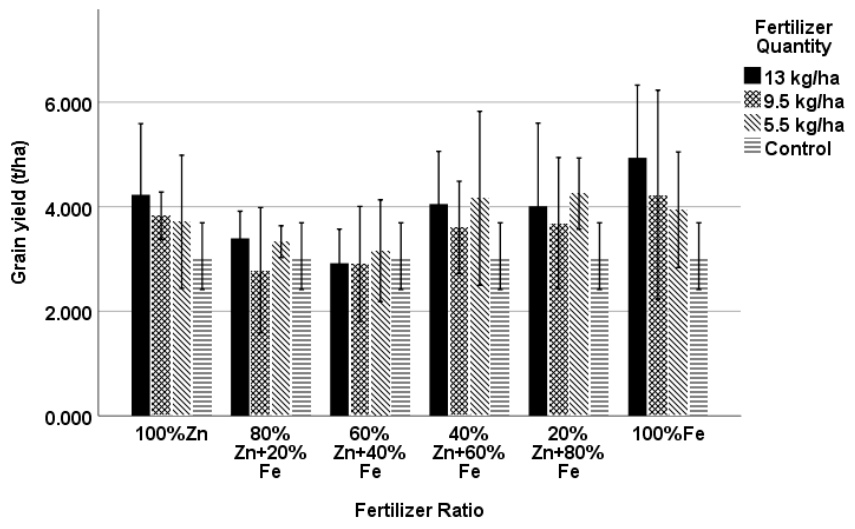
Figure 2. Effect of combined foliar application of Zn and Fe on yield of winter wheat (Nongda 399 cultivar). Values are means of two cropping seasons. Vertical bars represent the 95% confidence interval.